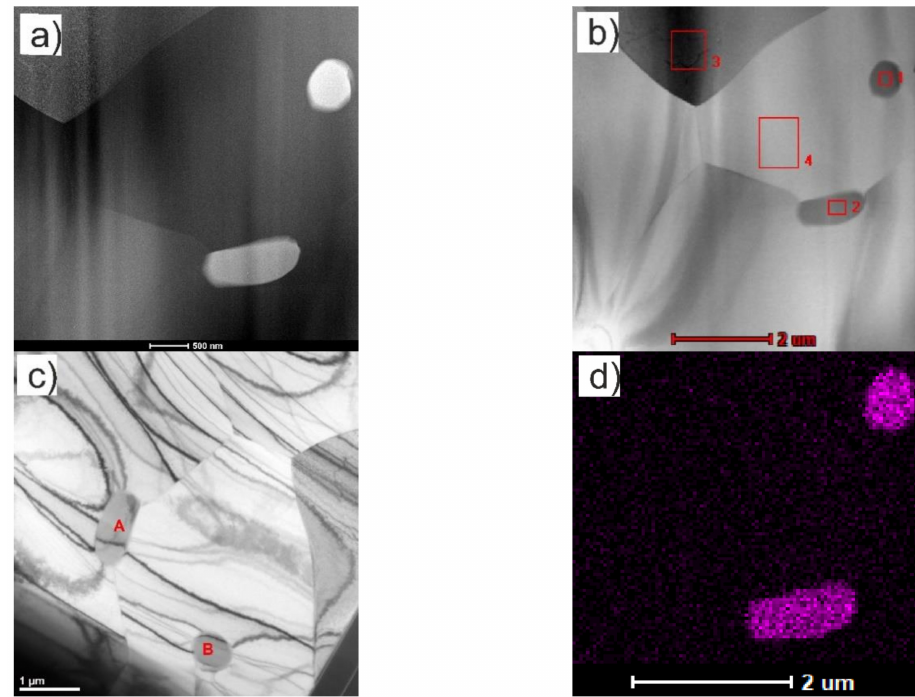
Figure 9. TEM micrographs showing the microstructure of the Ti + 20 wt %(Ti,Mo)C/C composite (the lamella)—surface per- pendicular to the direction of composite growth: ( a – c ) TEM morphology obtained on HAADF and BF detectors, respectively, with marked points identified by electron diffraction method; points in the order of numbering from 1 to 4 correspond to the following phases: 1,2 correspond to phase β -Ti, (body-centered cubic phases with the lattice parameter a = 0.331 nm), while points 3,4 correspond to phase TiC; ( d ) EDS mapping of the Mo (violet) distribution in the lamella material.